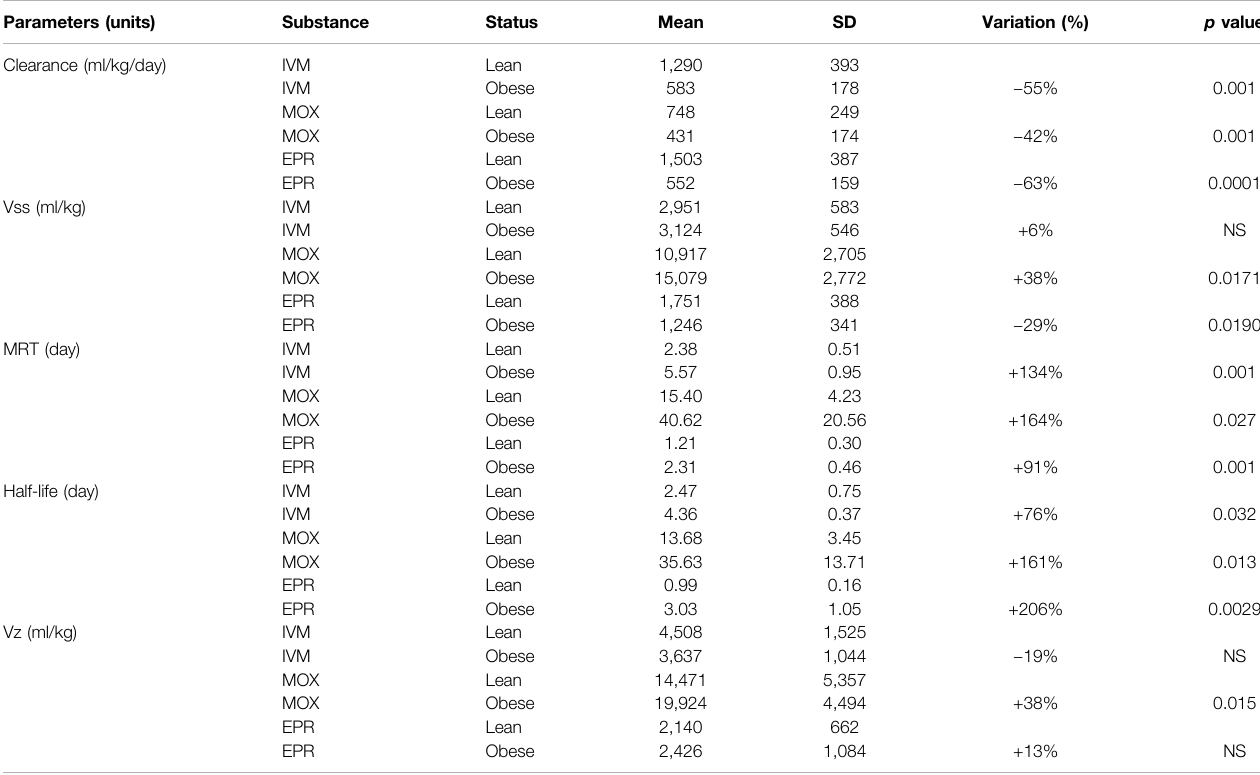
TABLE 1 | Results of the NCA analysis (Model 200 – 202, Log-linear trapezoidal rule) for the three drugs and seven dogs. Parameters